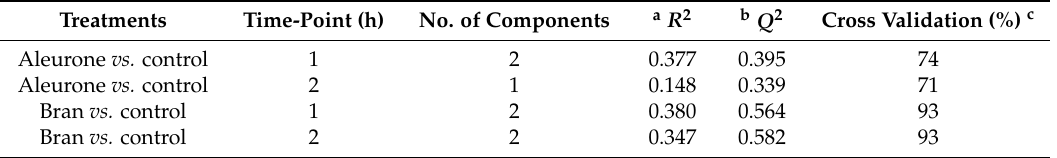
a multiple correlation coefficient ( R 2 ) an estimate of goodness of fit of model to the data; b cross validation